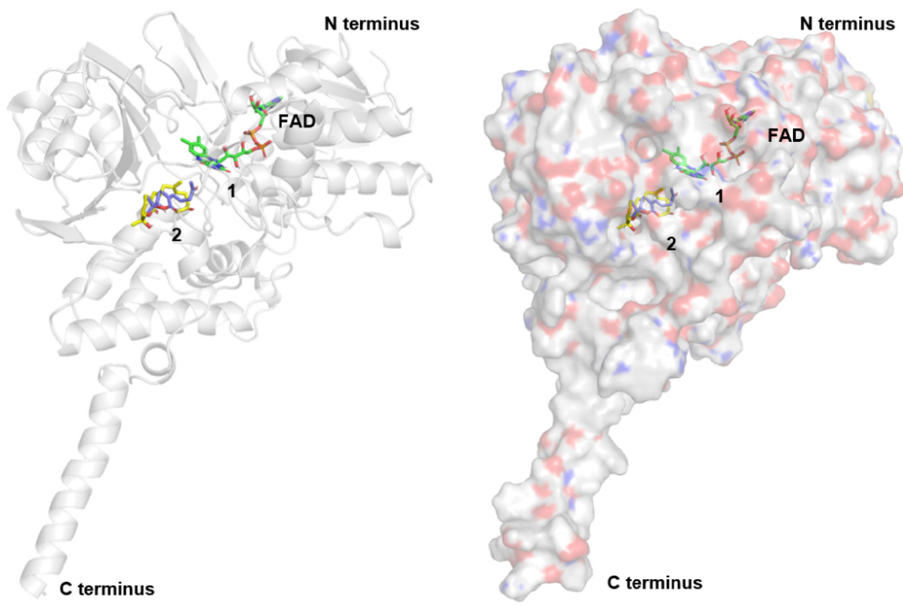
Figure 4. Binding model of compounds 1 and 2 in human monoamine oxidases A crystal structure (Protein Data Bank ID: 2Z5X).